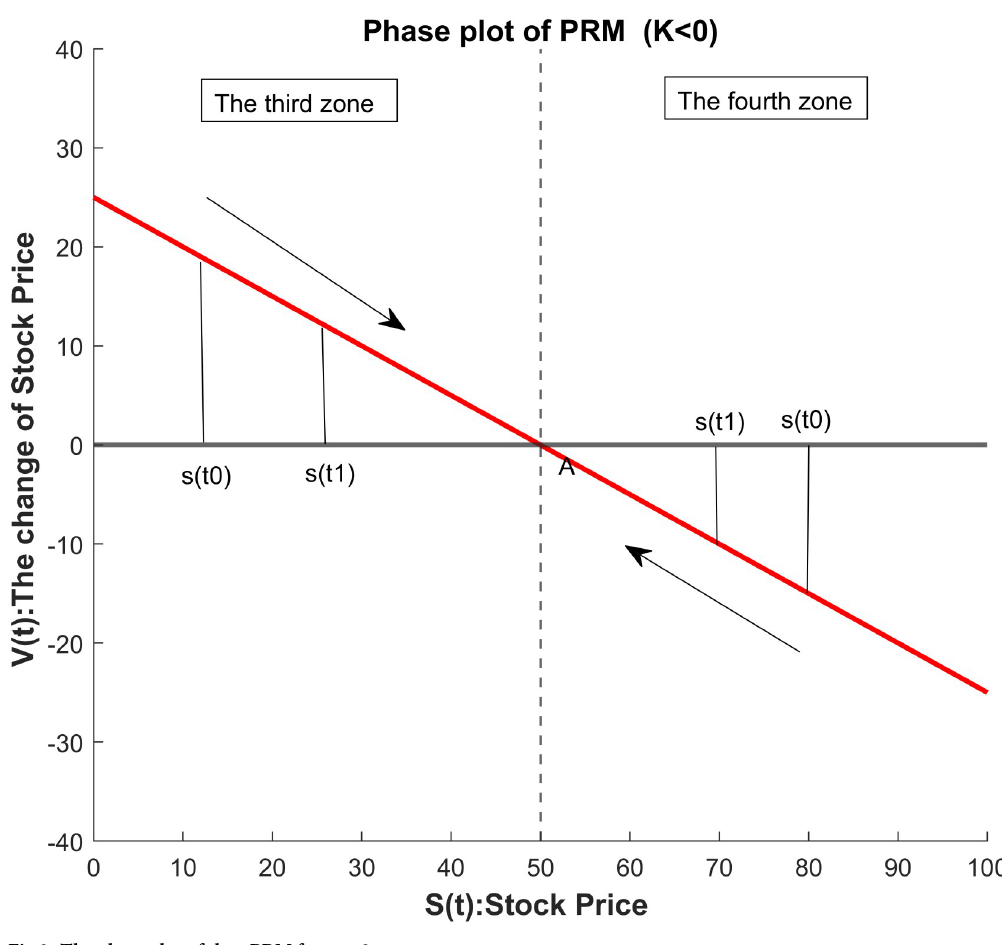
Fig 2. The phase plot of the nPRM for κ <